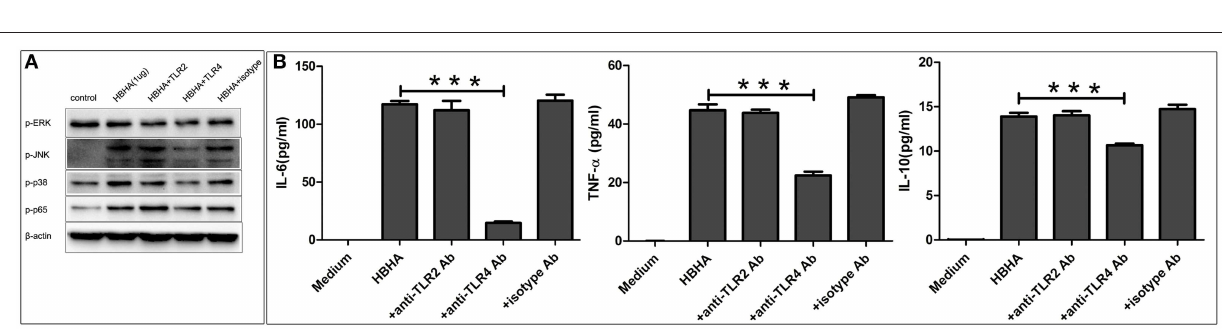
FIGURE 8 | Toll-like receptor 4 (TLR4) is required for the HBHA-stimulated activation of MAPK and NF- κ B signaling pathways, and the secretion of cytokines in macrophages. (A) THP-1 cells were pretreated with anti-TLR2 (10 µ g/ml), anti-TLR4 (10 µ g/ml), or isotype control antibodies (10 µ g/ml) for 1h and were then induced with HBHA for 30min, and the phosphorylation levels of p38, JNK, ERK1/2, and p65 were detected by western blotting. (B) THP-1 cells were pretreated with blocking antibodies for 1h and were then stimulated with HBHA. The levels of IL-6, TNF- α , and IL-10 in the supernatants were measured by ELISA after 18h. Data are expressed as the mean ± SD from three independent experiments. *** P <